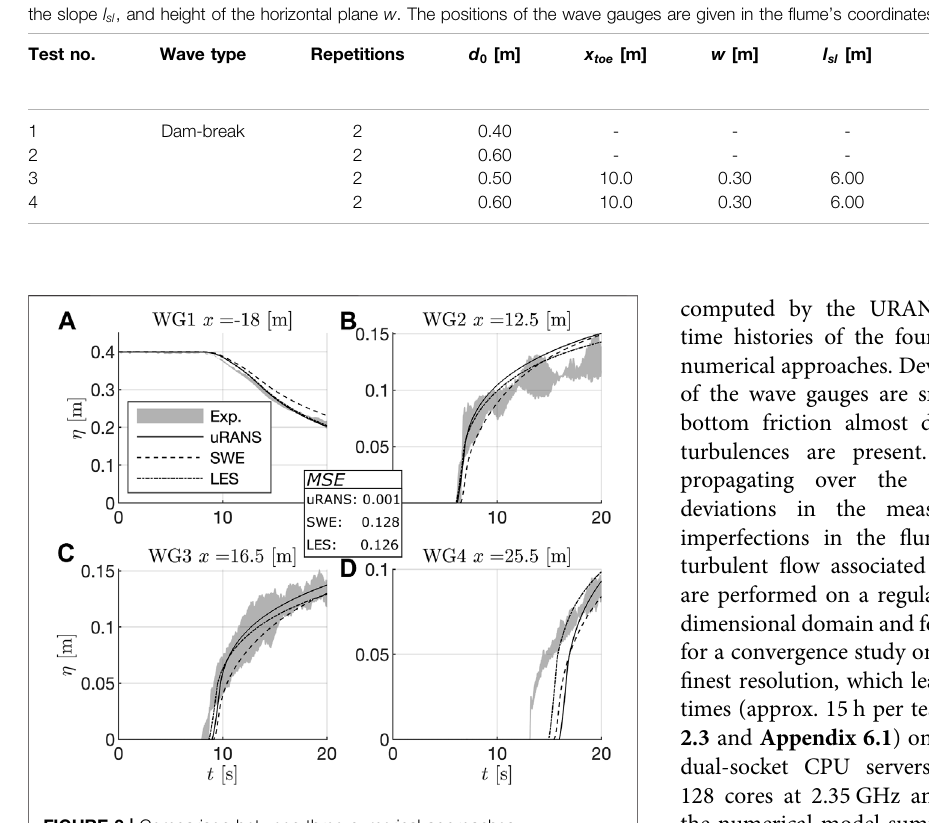
FIGURE 3 | Comparison between three numerical approaches compared against experimental data of a dam-break wave propagating on a fl at bottom (test no. 1, see Table 1 ). Four wave gauge time histories are displayed; one in the reservoir section (A) and three in the propagation section (B-D) of the fl ume. The mean squared errors (MSE) over all four time histories are